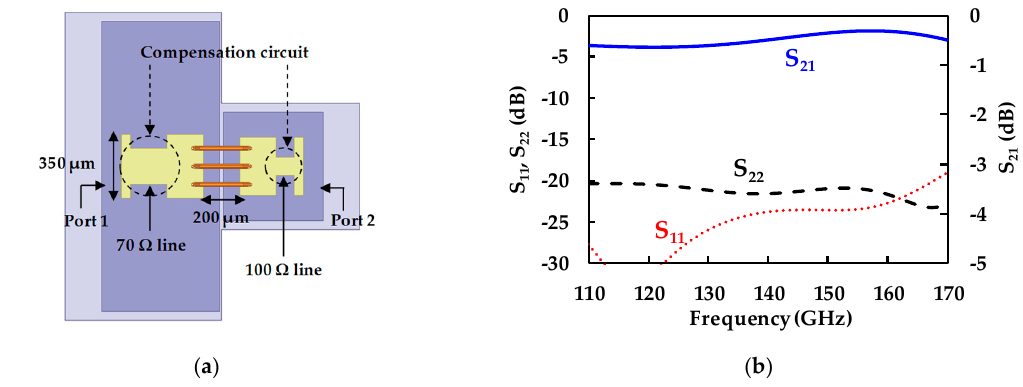
Figure 11. Bond ‐ wire compensation circuit. ( a ) Top view and ( b ) simulated results.